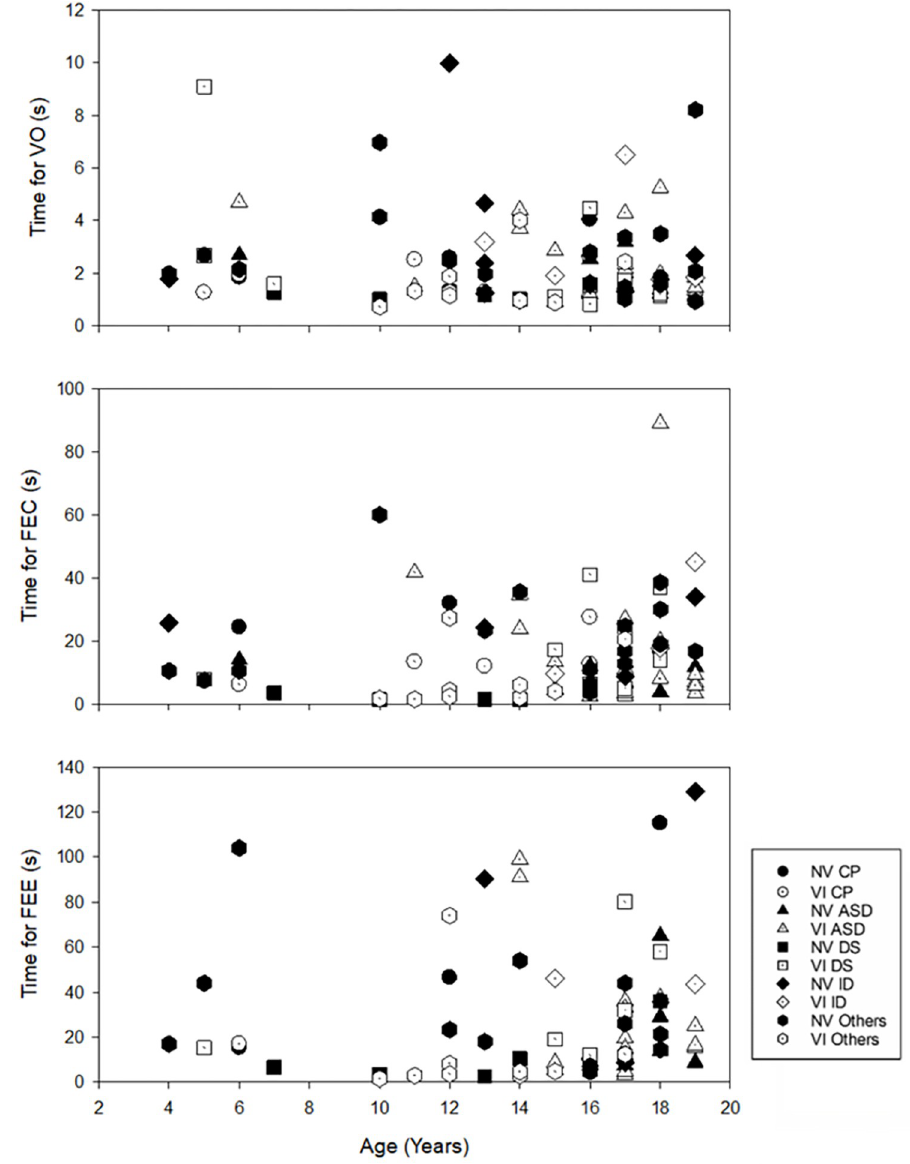
Fig 3. Relationship between visual processing functions and chronological age, stratified by visual acuity and subtypes of SEN. Filled symbols indicate students with visual acuity < LogMAR 0.50 (NV), while dotted symbols indicate students with visual acuity � LogMAR 0.50 (VI). Circle: Cerebral palsy (CP); Triangle: Autism spectrum disorder (ASD); Square: Down syndrome (DS); Diamond: Isolated intellectual disability (ID); Hexagon: Other